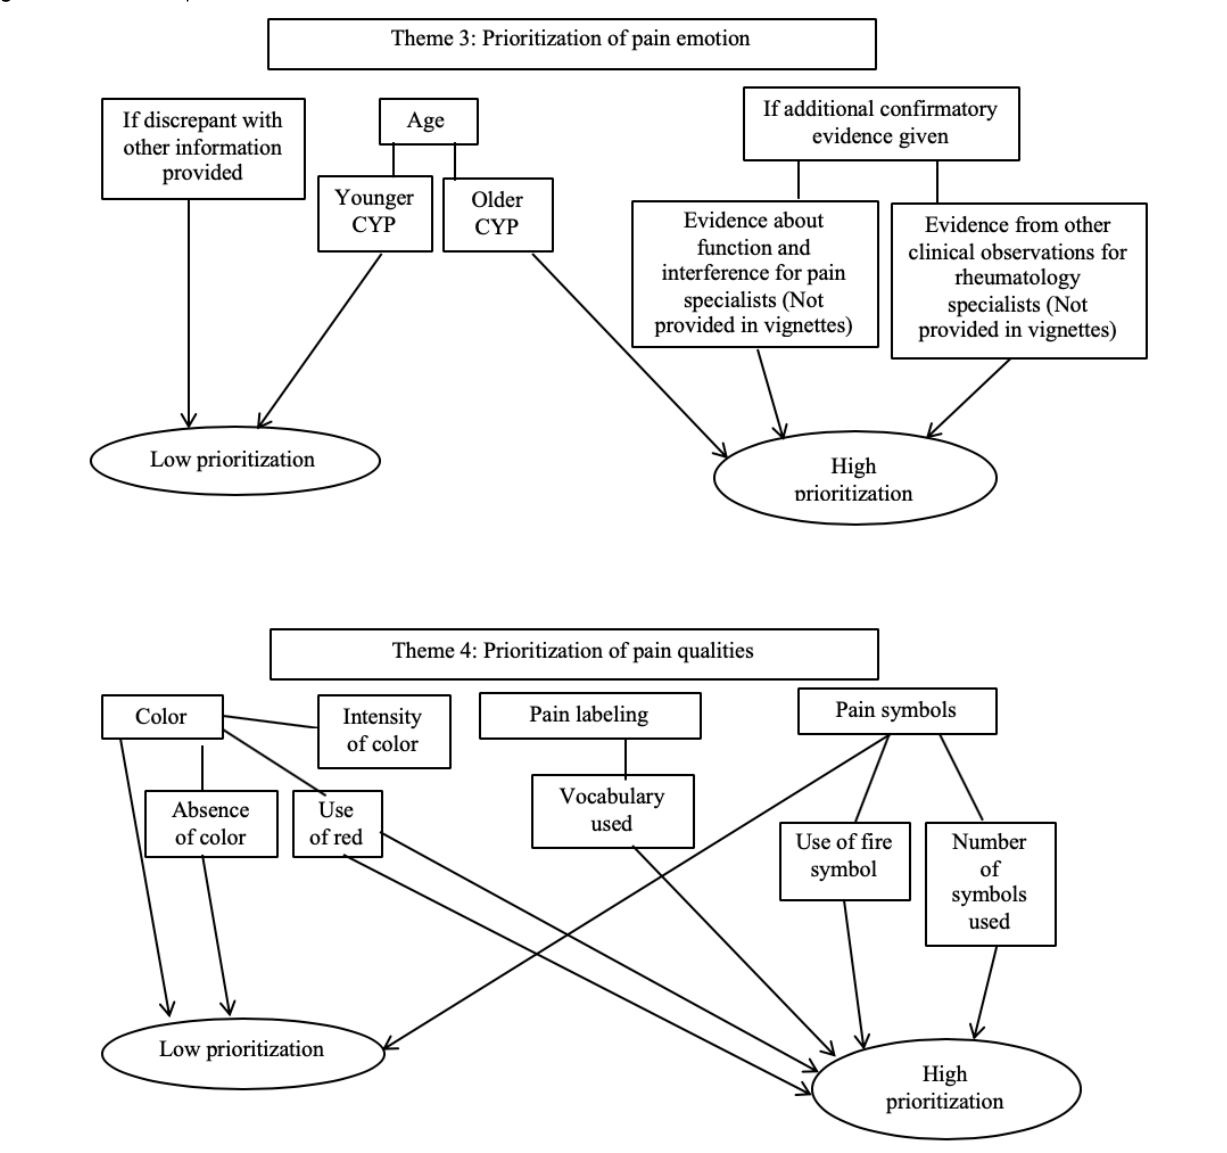
Figure 3. Thematic maps for themes 3 and